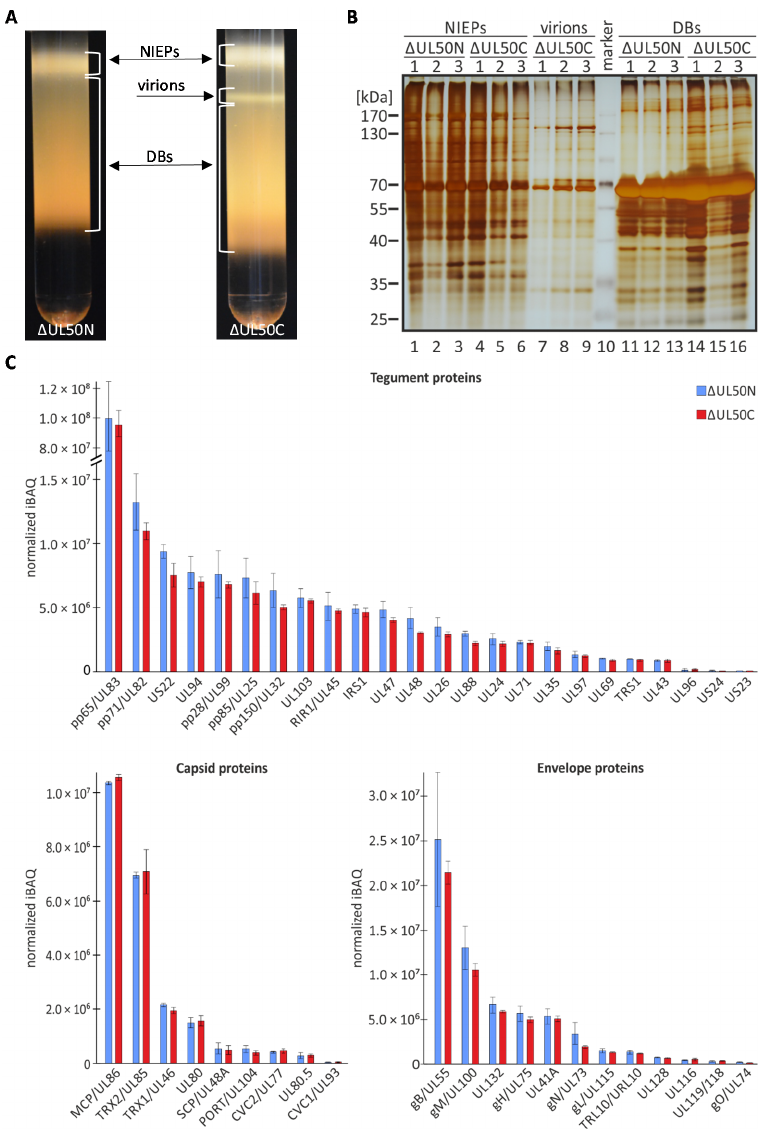
Figure 5. MS-based quantitative analysis of gradient-purified ∆ UL50C and ∆ UL50N NIEPS. ( A ) Pu- rification of the ∆ UL50 virus grown on pUL50-complementing ( ∆ UL50C) or non-complementing cells ( ∆ UL50N) by glycerol–tartrate gradients resulting in three different fractions, i.e., dense bodies (DBs), noninfectious enveloped particles (NIEPs), and virions. Note that the absence of a detectable virion band, however, did not rule out a minor fraction of infectious virions in the preparations (see Figure 2). ( B ) Silver staining of the purified DB, NIEP, and virion fractions. ( C ) MS-based quantitative analysis of ∆ UL50N and ∆ UL50C NIEP fractions. The abundance of the detected proteins was calcu- lated as the averaged and extracted intensity-based absolute quantitation (iBAQ) value, normalized to the mean of MCP and TRX1 iBAQ values. Mean values of biological triplicates ± SD are given and proteins were categorized into the three localization subclasses tegument, capsid, and